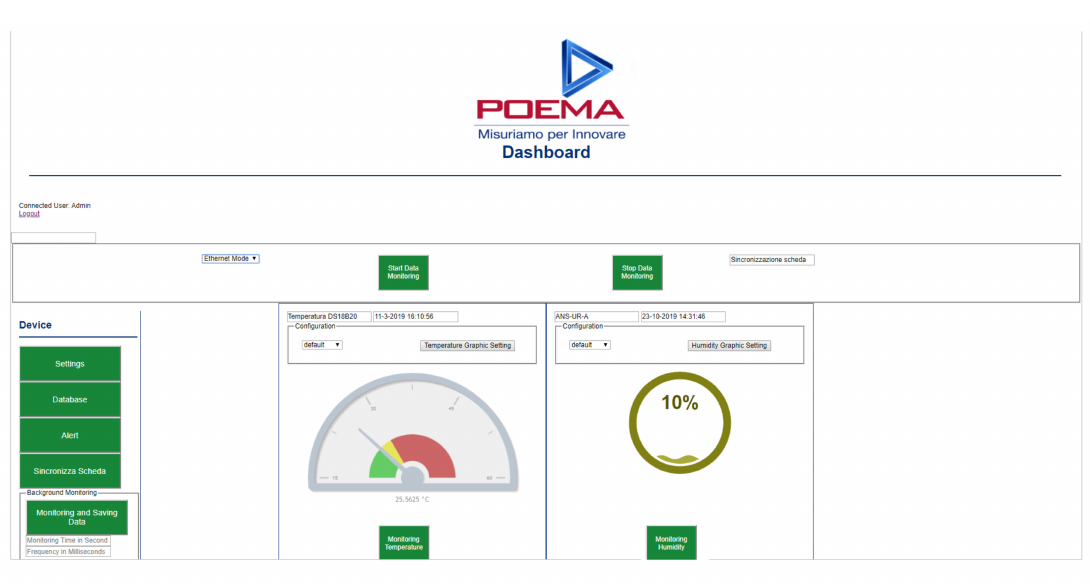
Figure 14. A screenshot of the dedicated Web